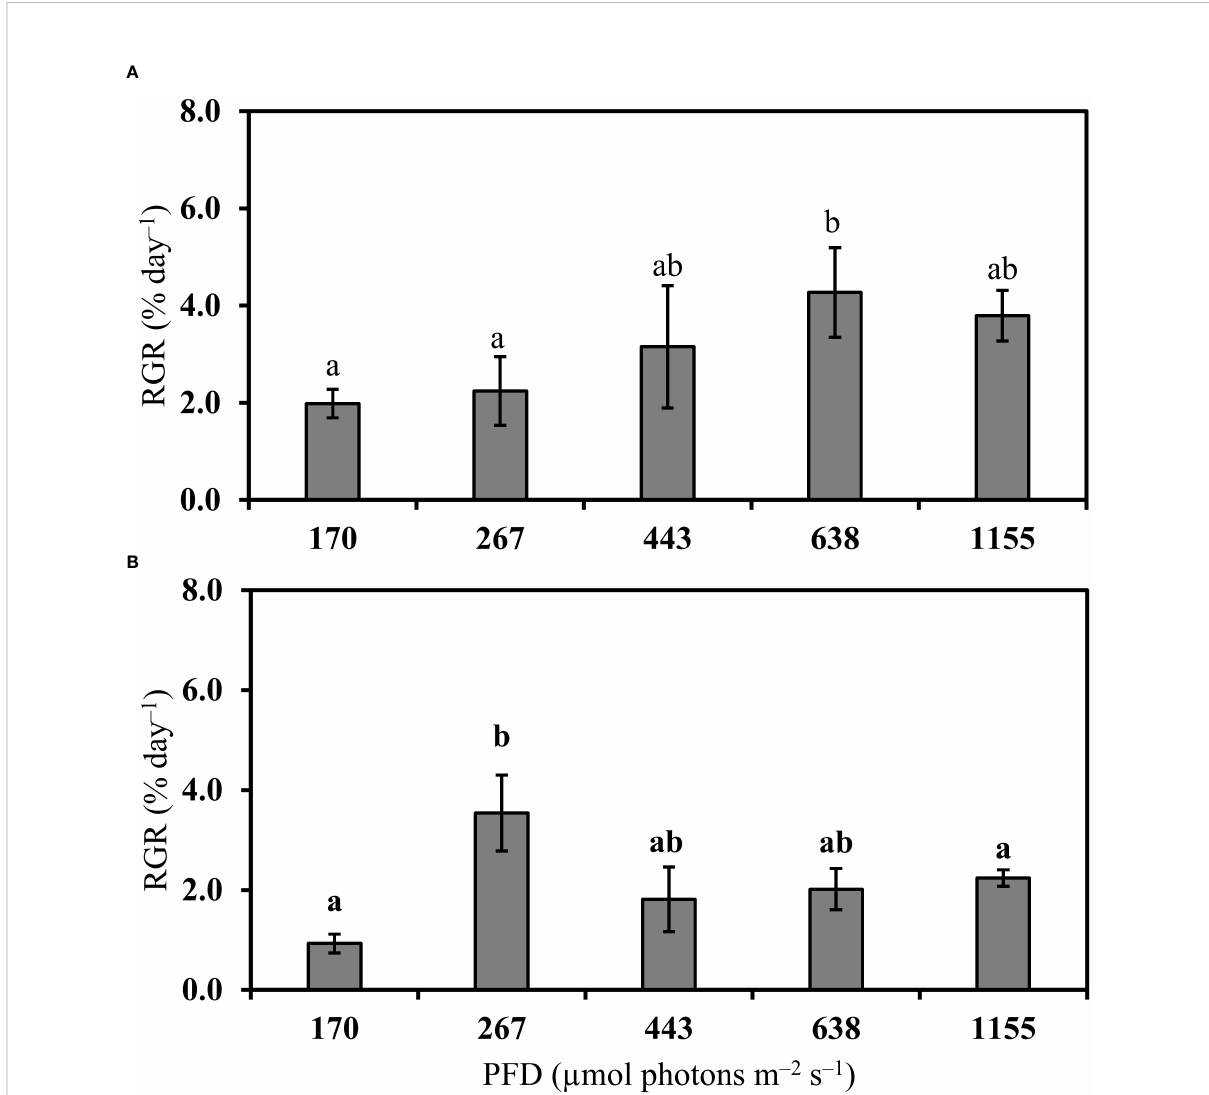
FIGURE 2 Relative growth rate (RGR, % day – 1 ) of Bostrychia calliptera (A) and B. montagnei (B) cultured under different photon fl ux densities (PFDs) for 14 days. Columns are means and bars are standard deviations based on four replicates ( n = 4). Different non-bold and bold letters above bars indicate statistical differences ( p < 0.05) among PFD treatments for B. calliptera and B. montagnei , respectively, by one – way ANOVA or Kruskal – Wallis ’ s test (Table S1) followed by associated post hoc